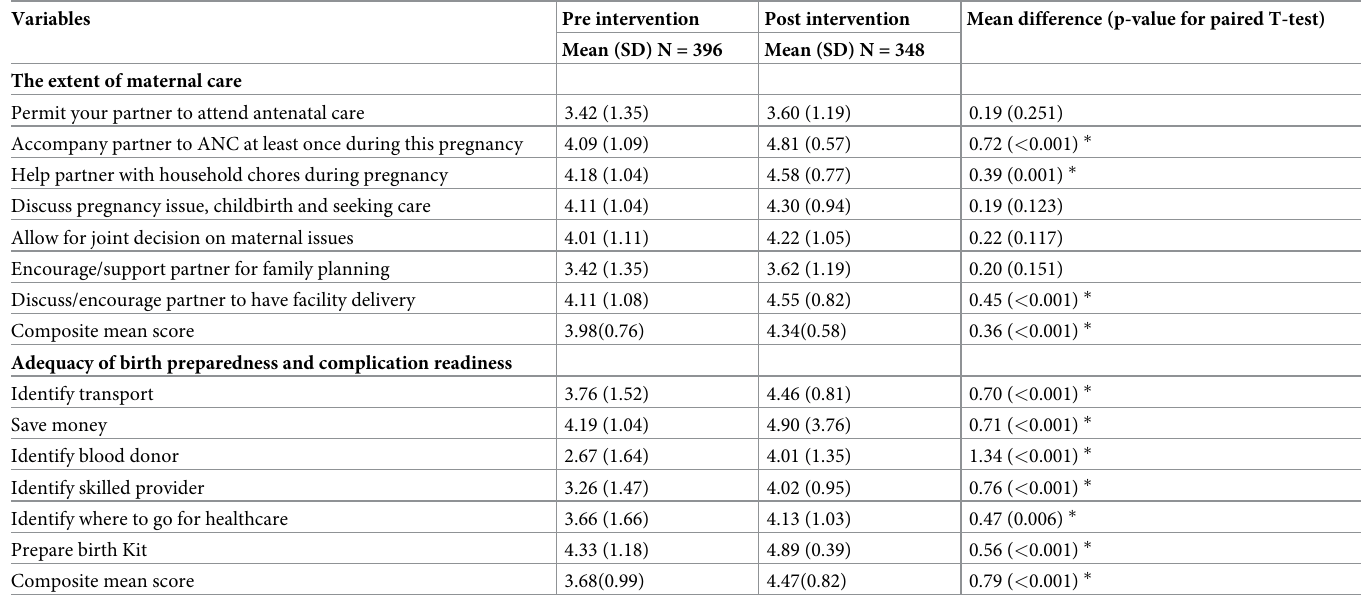
Table 4. Safe motherhood practices among men in rural Ebonyi communities at pre and